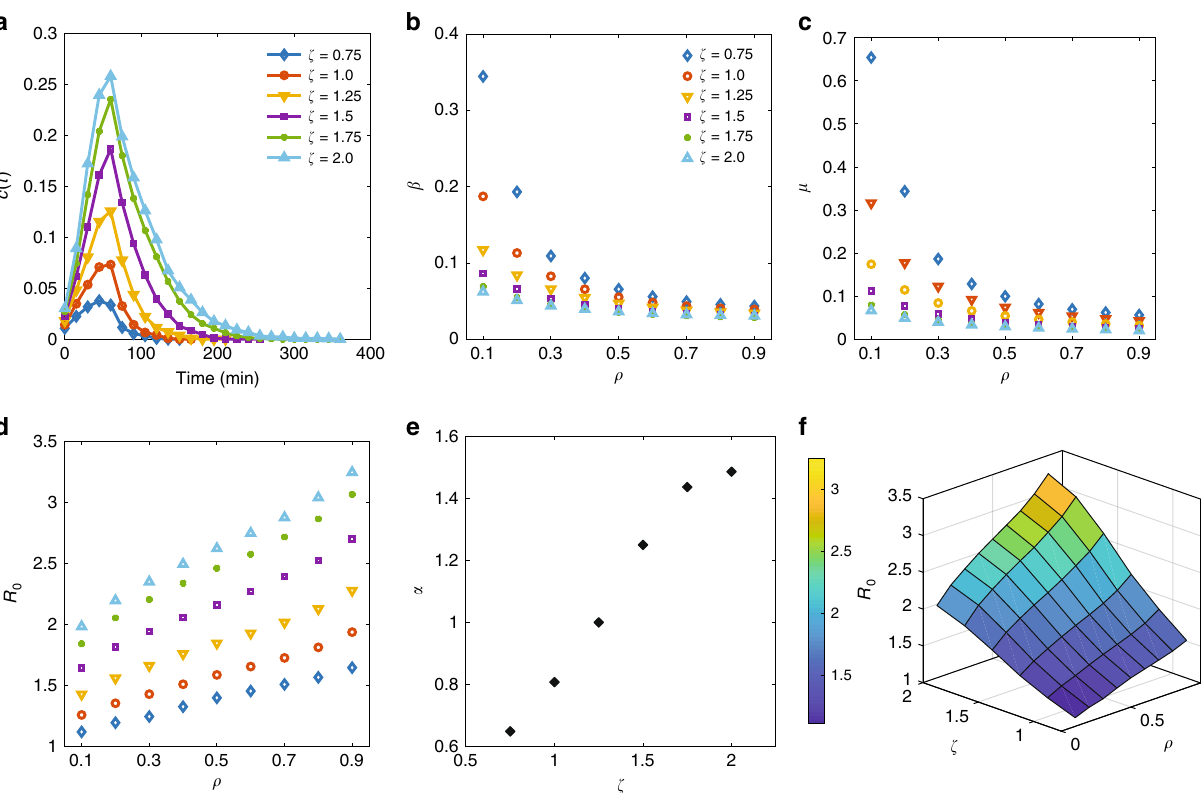
Fig. 7 Effect of travel demand on congestion dynamics. Propagation and dissipation of congestion in the Melbourne network subject to 1-h demand followed by a recovery period: a evolution of fraction of congested links in the network over time for various demand levels given ρ = 0.3; b and c estimated model parameters β and μ for various ρ and demand levels; d R 0 as a function of ρ for various demand levels; e sensitivity of α to ζ . Here, α represents the slope of a linear fi t to the data shown in d . f Three-dimensional illustration of the relationship between R 0 , ρ , and ζ